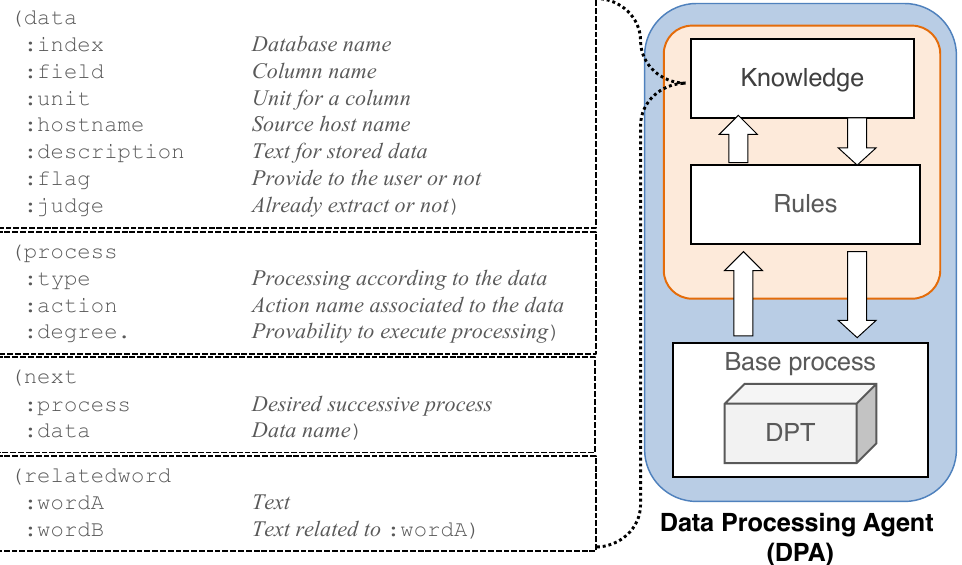
Figure 4. List of data-processing knowledge for the DPA. A dashed square indicates each knowledge element. Each knowledge element is defined as a separate agent